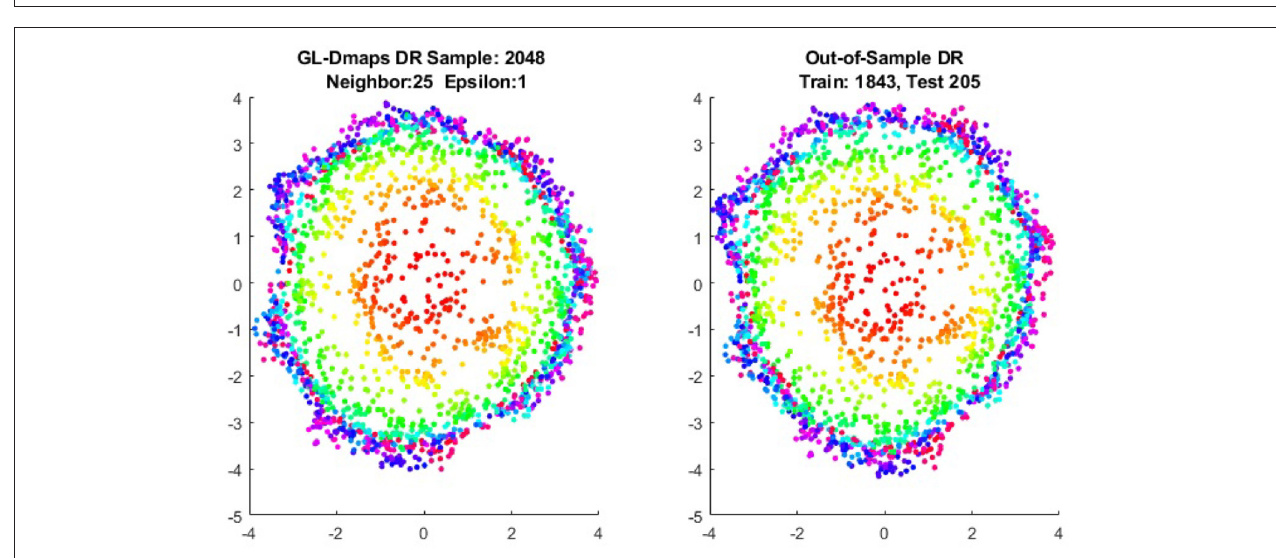
FIGURE 3 | GL out-of-sample extension for DR of Punched